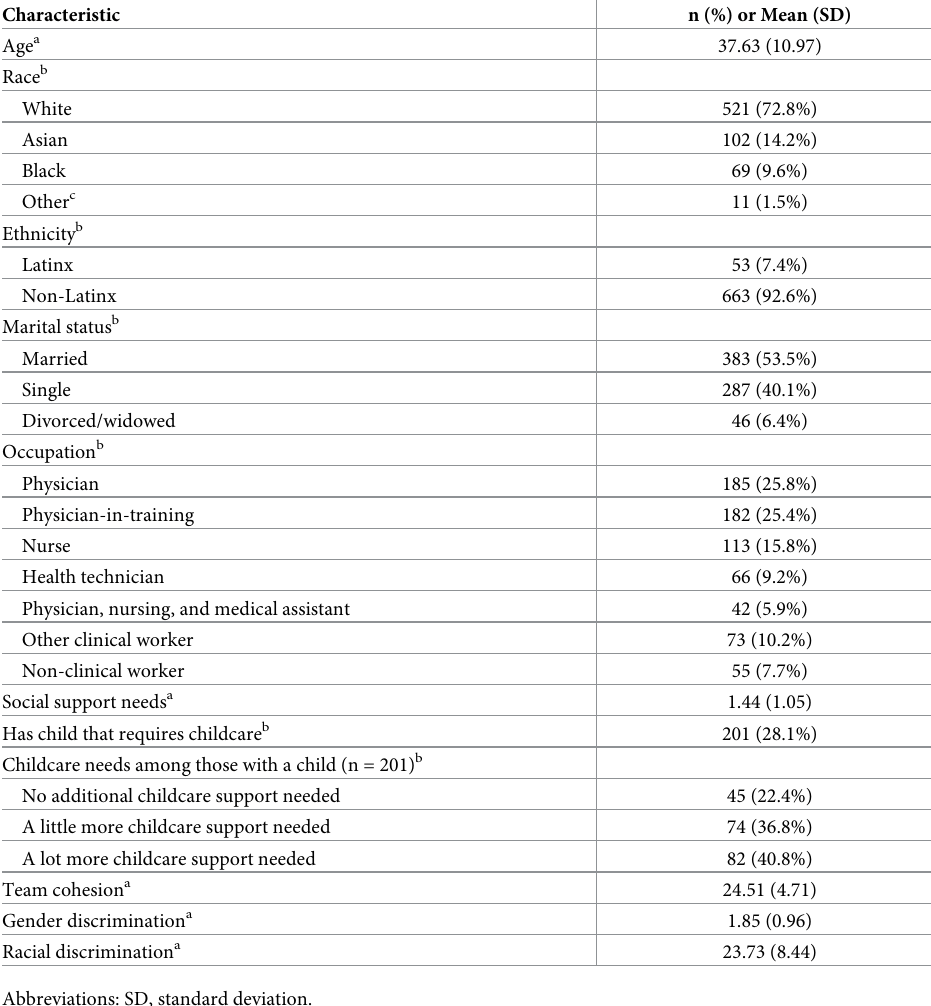
Table 1. Participant